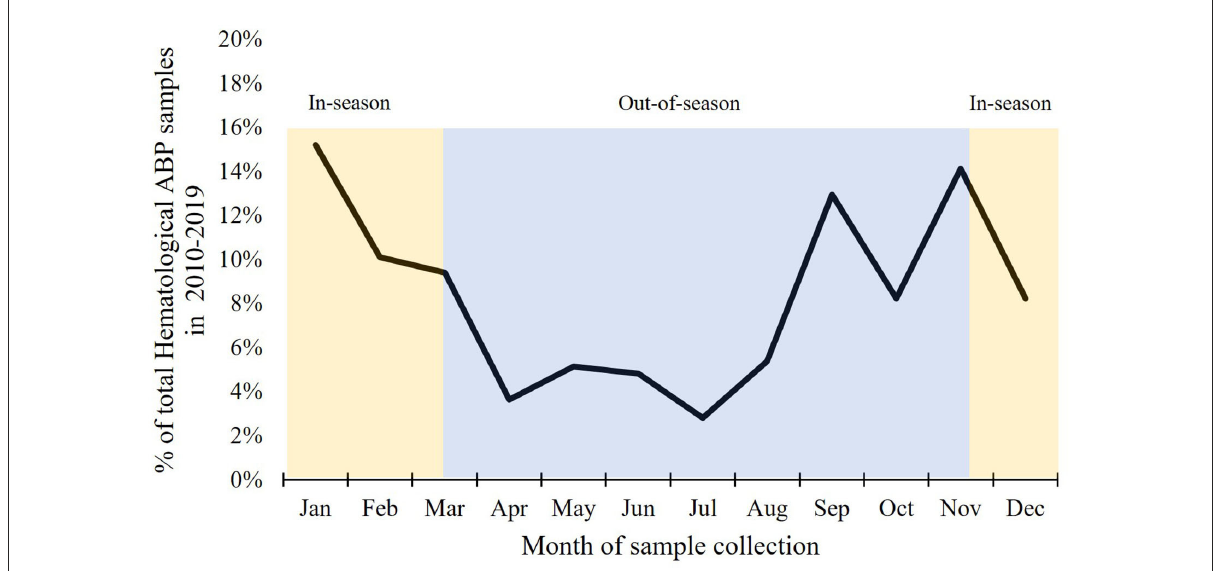
FIGURE3 Distribution of samples per month for Biathlon, Cross-Country Skiing and Nordic Combined for the period